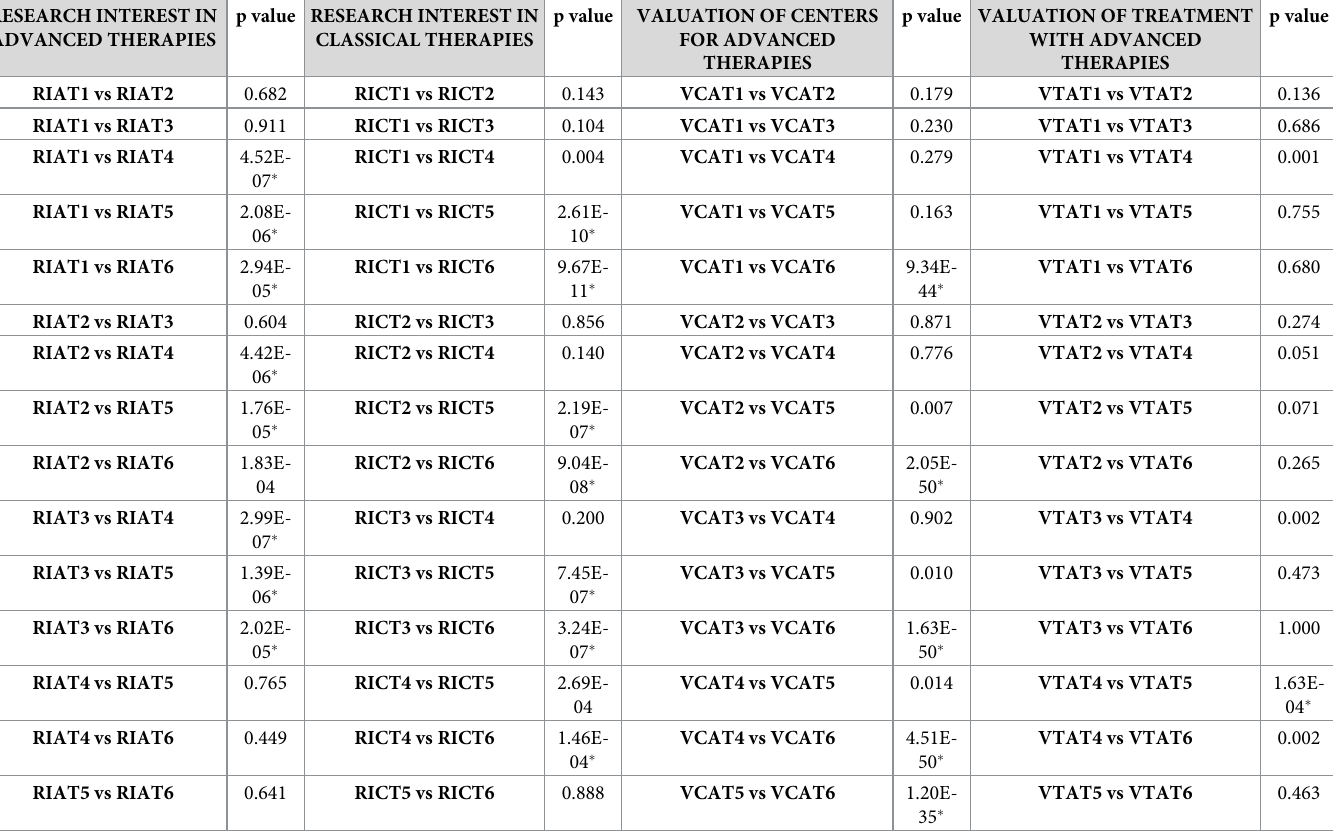
Table 7. Statistical p values for pairwise comparisons of two specific items included in each topic of the attitudinal component. RESEARCH INTEREST IN p value RESEARCH INTEREST IN p value VALUATION OF CENTERS ADVANCED THERAPIES CLASSICAL THERAPIES FOR